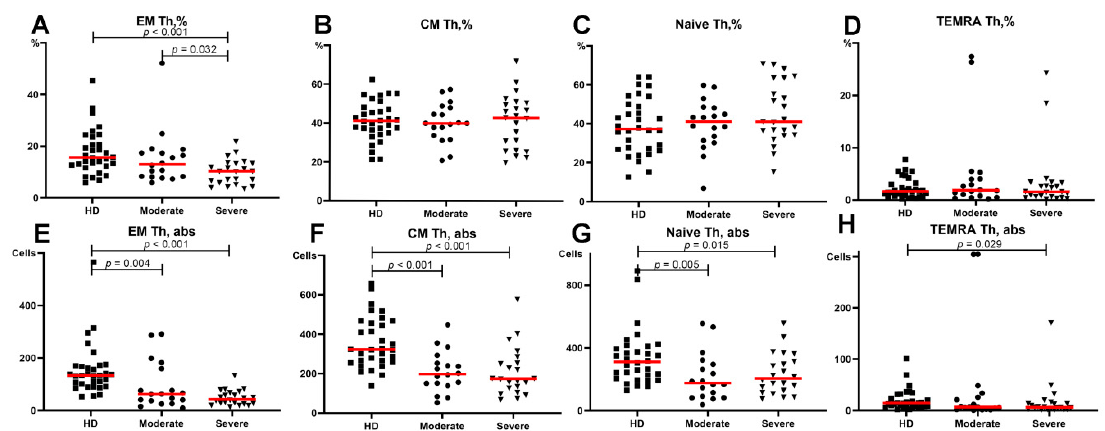
Figure 4. Basic Th cell subsets in patients with COVID-19 and in healthy donors. ( A ) Relative count of EM Th cells. ( B ) Relative count of CM Th cells. ( C ) Relative count of naïve Th cells. ( D ) Relative count of TEMRA Th cells. ( E ) Absolute number of EM Th cells. ( F ) Absolute number of CM Th cells. ( G ) Absolute number of naïve Th cells. ( H ) Absolute number of TEMRA Th cells. EM, effector memory; CM, central memory; TEMRA, T effector memory re-expressing CD45RA. Red lines demonstrate Median value.